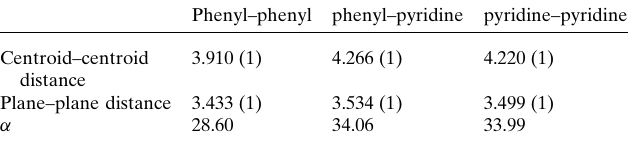
Table 2 Distances and (cid:5) angle (A˚ , (cid:4) ) of intermolecular (cid:2) – (cid:2) interactions in 3 . Phenyl–phenyl phenyl–pyridine pyridine–pyridine Centroid–centroid